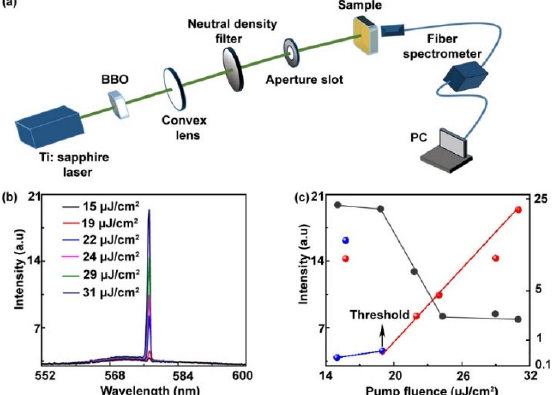
Figure 5. Lasing behavior of the circular periodic DFB polymer lasers. ( a ) Schematic optical layout used for pumping lasing device. ( b ) Optical emission spectra at different pump fluences. ( c ) Evolution of the output intensity and the full width at half maxima as function of pump fluence. The black arrow in the graph indicates the threshold of the circular periodic DFB polymer laser about 19 µ J/cm